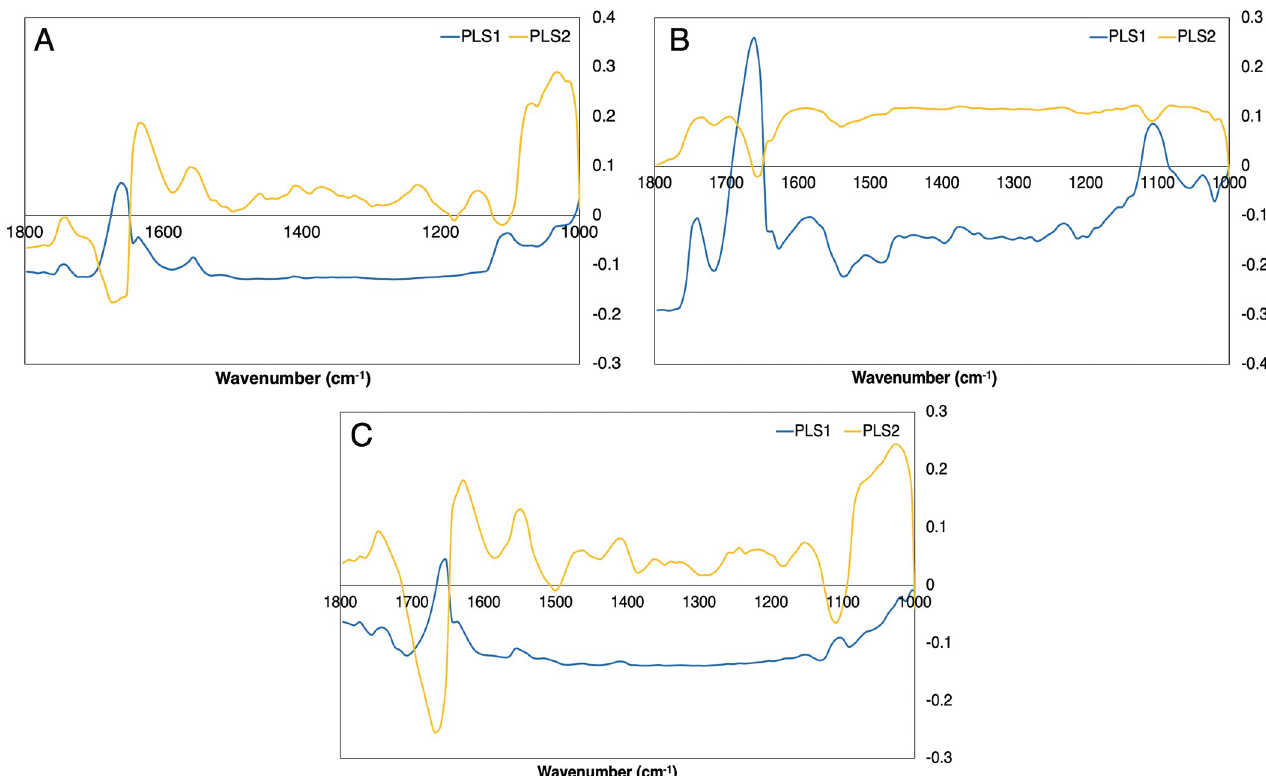
Fig 4. PLS loadings plots for the 1 st and 2 nd latent variables (LVs) for the unfiltered whole serum. (A) GBM versus non-cancer, (B) Lymphoma versus non- cancer and (C) GBM versus lymphoma.